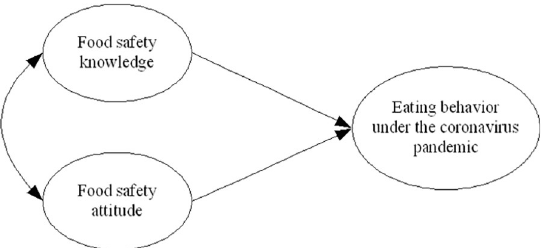
Fig 1. Model of relationships among food safety knowledge, attitude and eating behavior under the global coronavirus pandemic and varying lockdowns.